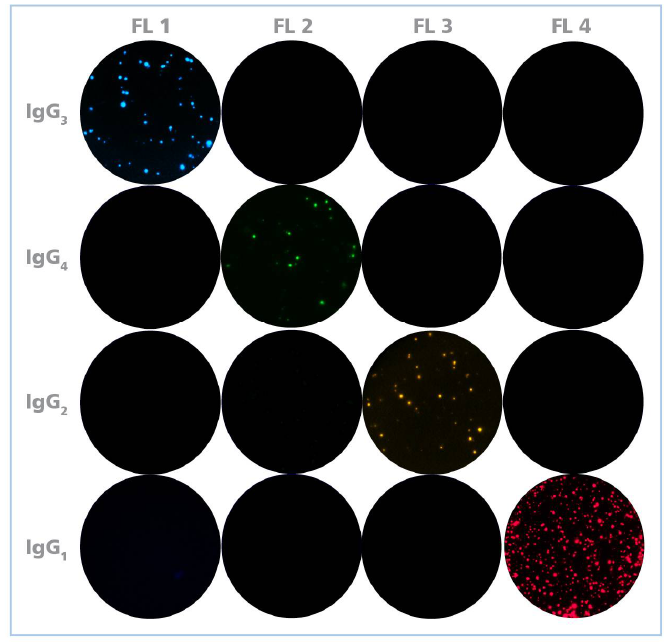
Figure 1. Unambiguous detection of the four fluorescent tags identifying the individual IgG subclasses. In each row, a single-color B cell ELISPOT assay was performed using the respective IgG subclass-specific detection reagent, as specified in the figure. Each assay was analyzed with filter settings optimized for the individual colors. Across three independent experiments (of which representative scans are shown), individual florescent channels (FL1 to FL4), readily detected corresponding fluorescent tags. Importantly, no cross-bleeding of colors between channels occurred.